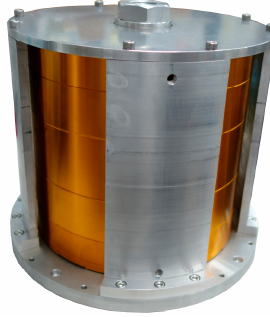
Energies 2016 , 9 , 1051